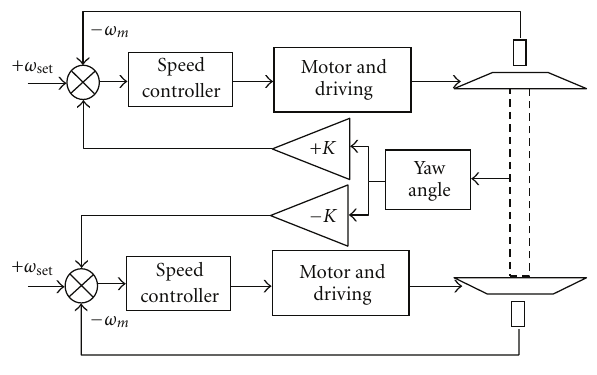
Figure 1: The overall control